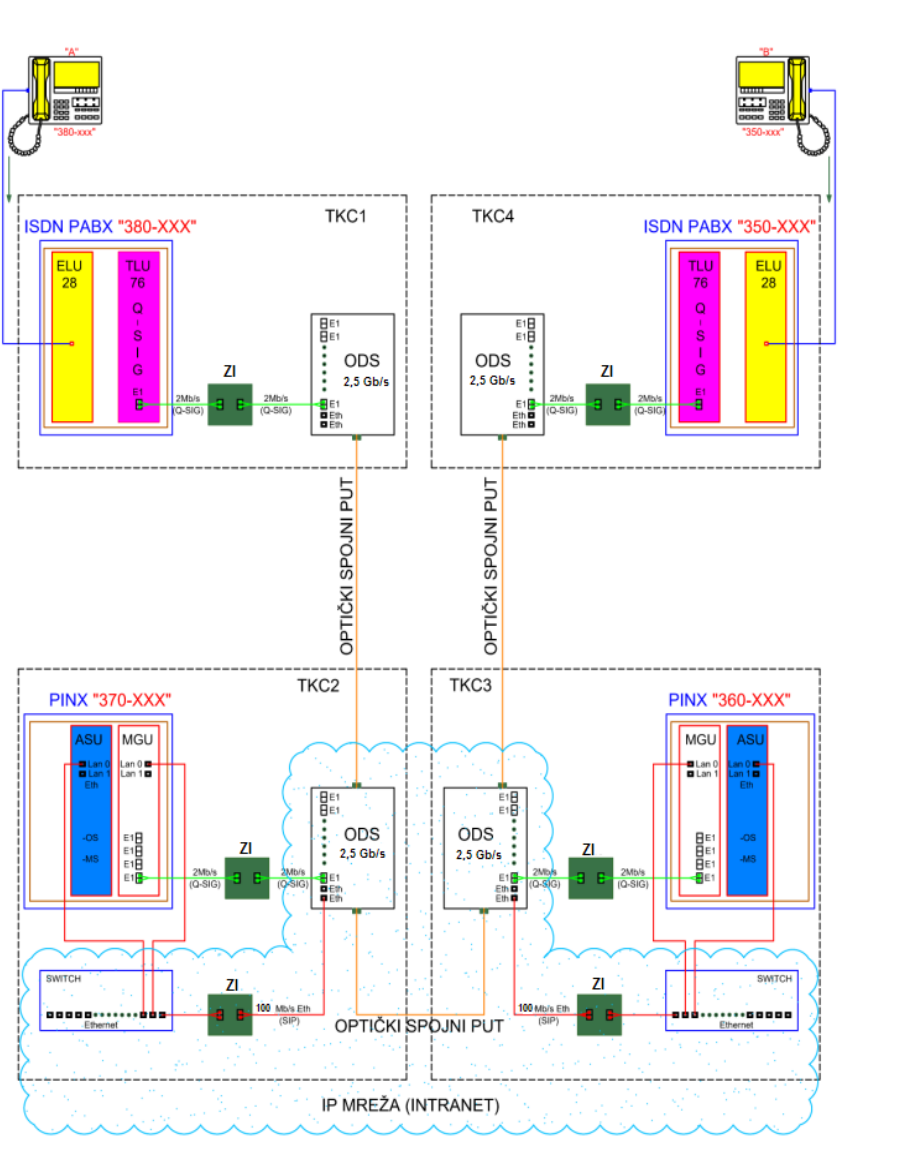
Figure 7 – Scenario of tunneling Q-SIG over the proprietary IP network with the SIP in the PATN SAF (Svrzić, 2019; Svrzić et al, 2019a) Рис. 7 – Сценарий туннелирования Q-SIG по проприетарной IP-сети с SIP в PATN Вооруженных Силах Республики Сербия (Svrzić, 2019; Svrzić et al, 2019a) Слика 7 – Сценарио тунеловања Q-SIG преко власничке IP мреже са SIP у ПАТлМр ВС (Svrzić, 2019; Svrzić et al,